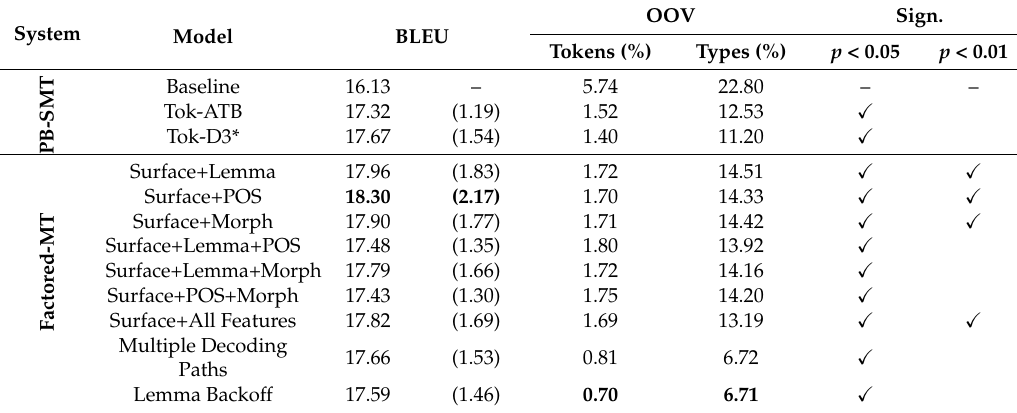
Table 3. BLEU scores with the improvement over the baseline model, along with the effects of pre-processing schemes and linguistic factors on the test set according to OOV rates. Besides, results of statistical significance test where (cid:88) indicates a significant improvement over the baseline with the specified p -value. The best result in terms of each metric (the highest BLEU and lowest OOVs) is highlighted in